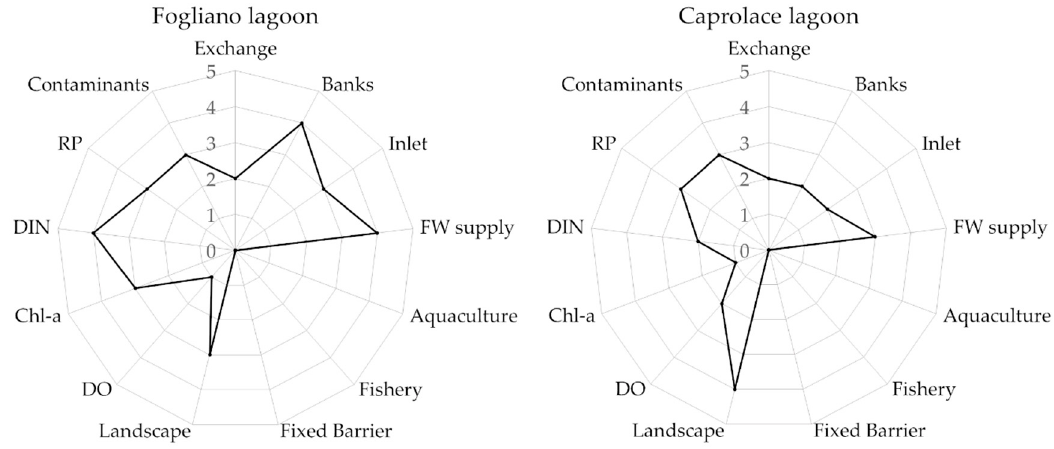
Figure 2. Environmental assessment of the lagoons: score values of indicators of anthropogenic pressure acting on Fogliano and Caprolace. Vectors represent: Water Exchange, Banks, Efficiency of Tidal Inlets and Freshwater supply (CPI-Morpho); Aquaculture, Fishery, Fixed barrier and Landscape (CPI-Use); Dissolved Oxygen (DO), Chlorophyll- α (Chl- α ); Dissolved Inorganic Nitrogen (DIN), and Reactive Phosphorus (RP) CPI-Qual.